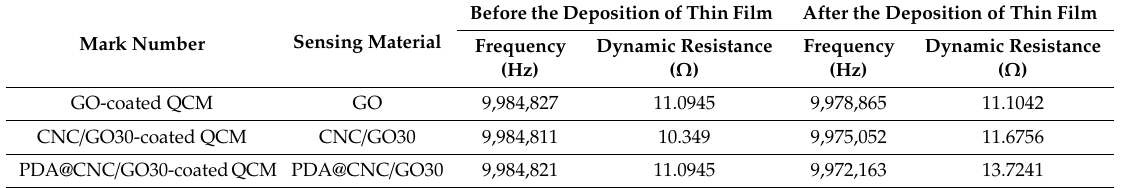
Table 1. Resonant parameters of QCM sensor before and after the deposition of thin film.